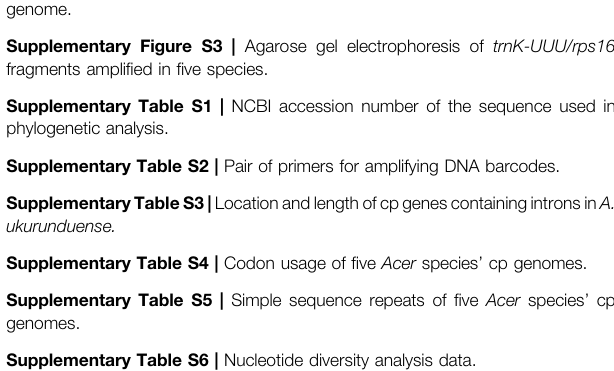
Supplementary Figure S2 | Divergence time analysis based on the chloroplast genome. Supplementary Figure S3 | Agarose gel electrophoresis of trnK-UUU/rps16 fragments ampli fi ed in fi ve species. Supplementary Table S1 | NCBI accession number of the sequence used in phylogenetic analysis. Supplementary Table S2 | Pair of primers for amplifying DNA barcodes.